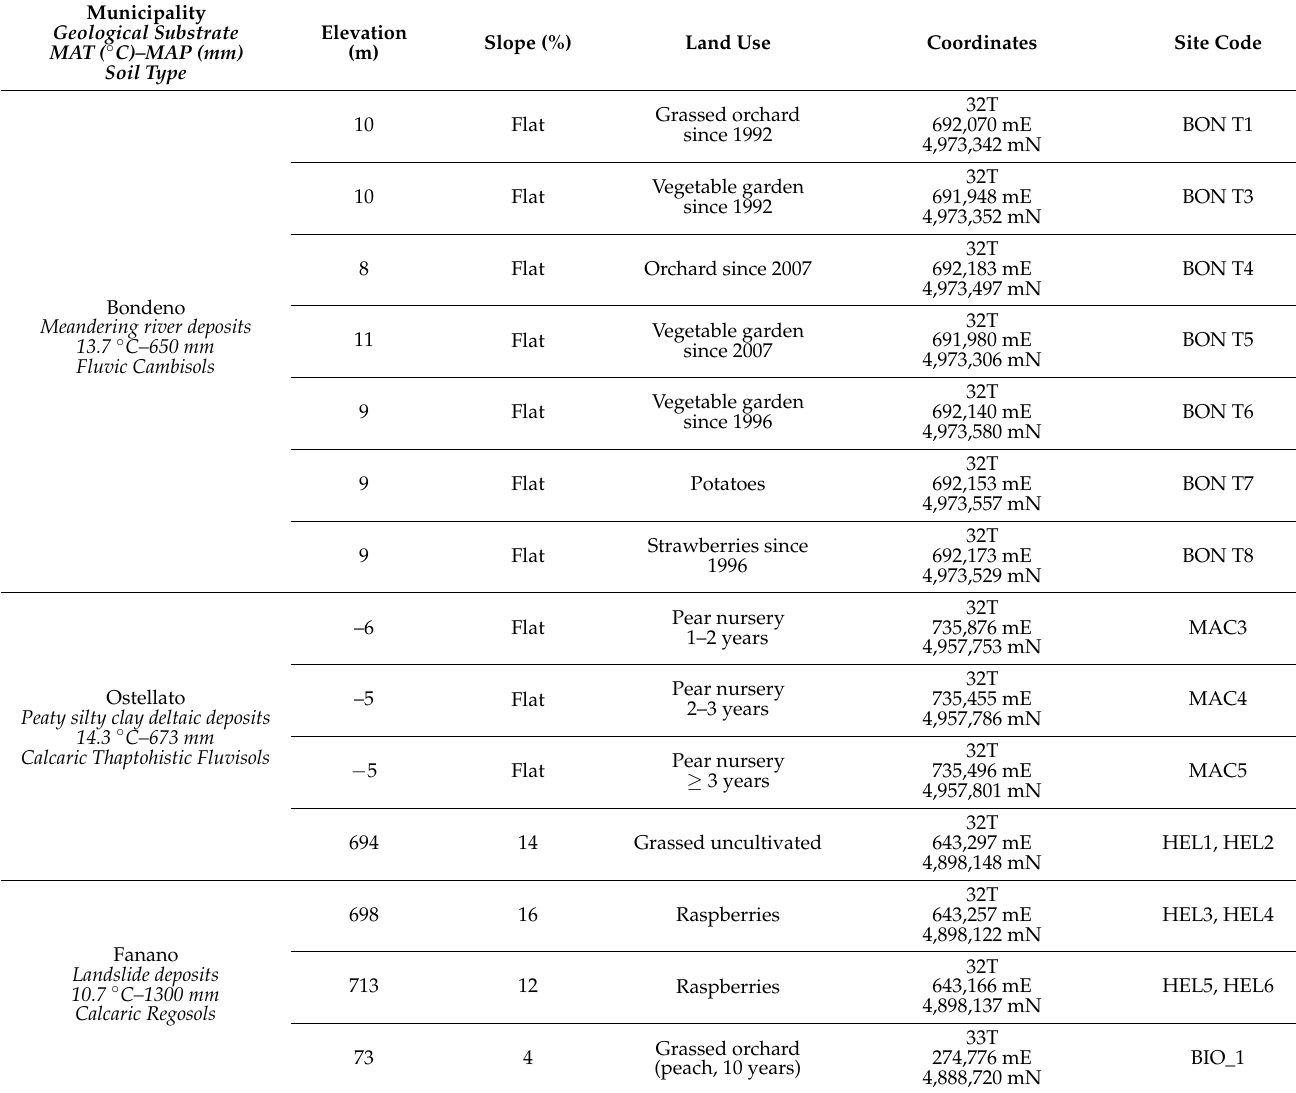
Table A1. Location and main features of the 54 investigated sites. Temperature (MAT, mean annual temperature) and precipitation (MAP, mean annual precipitation) are mean average for the period